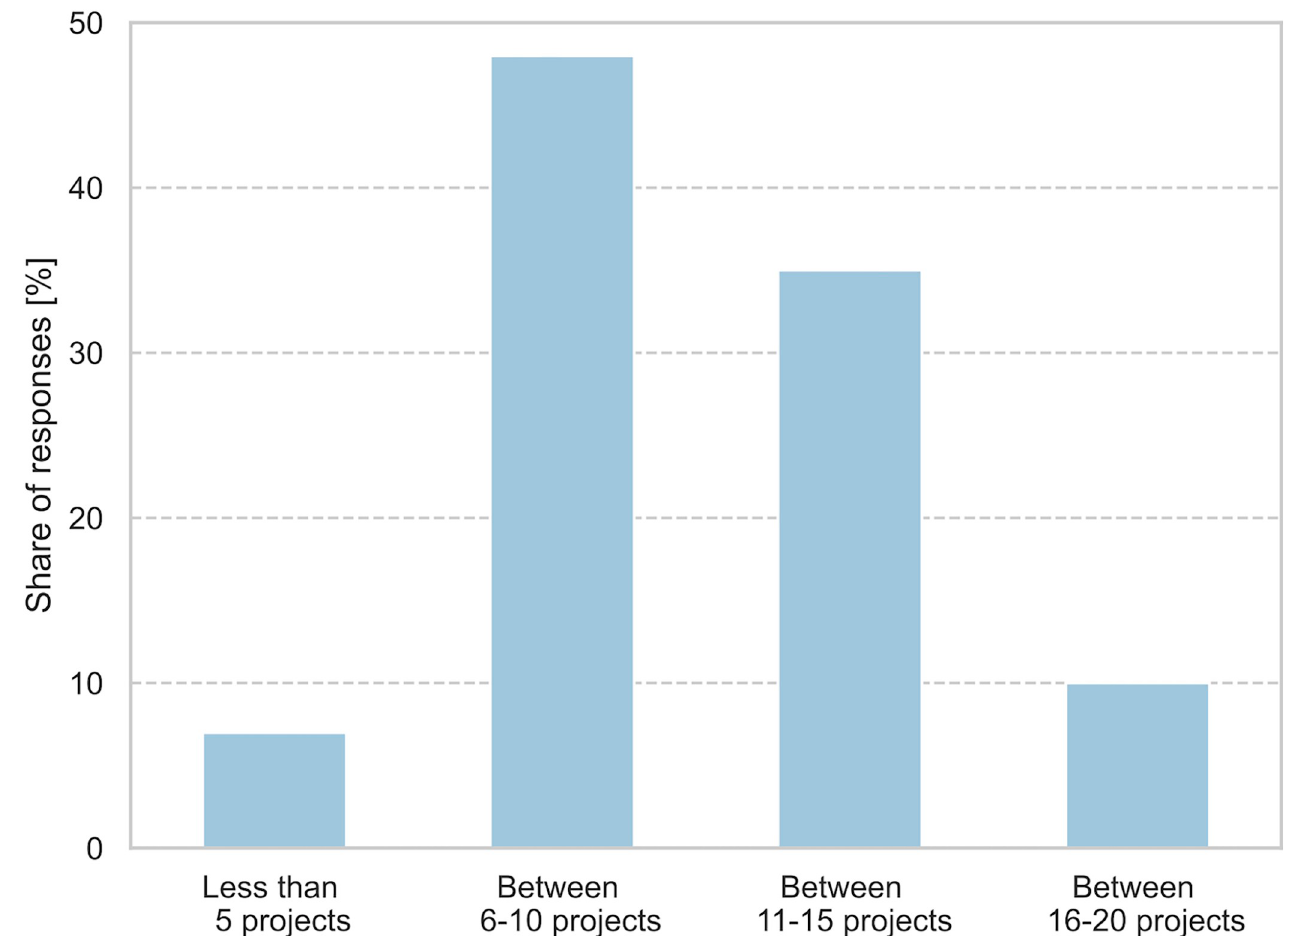
Fig 12. Share of responses for the different categories; responses were collected as single choice for the categories shown on the x axis. Each bar represents the share of responses for the respective category.